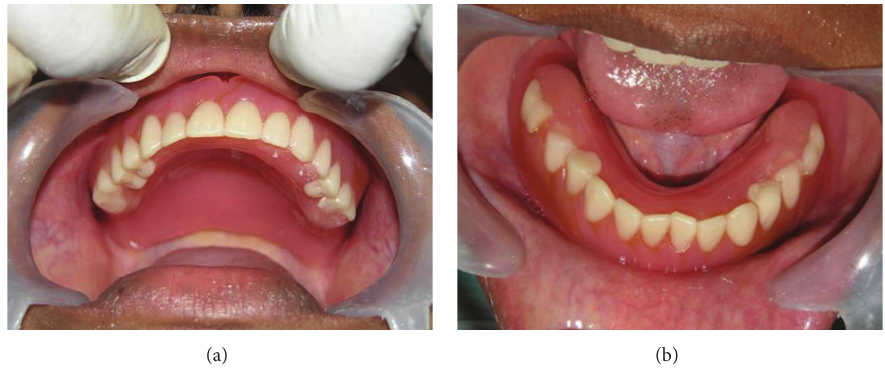
Figure 5: Conventional overdenture prosthesis inserted in the patient’s